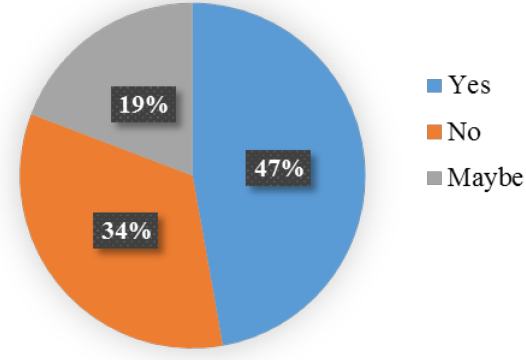
Figure - 9: Showing the preference of online learning over conventional teaching-learning